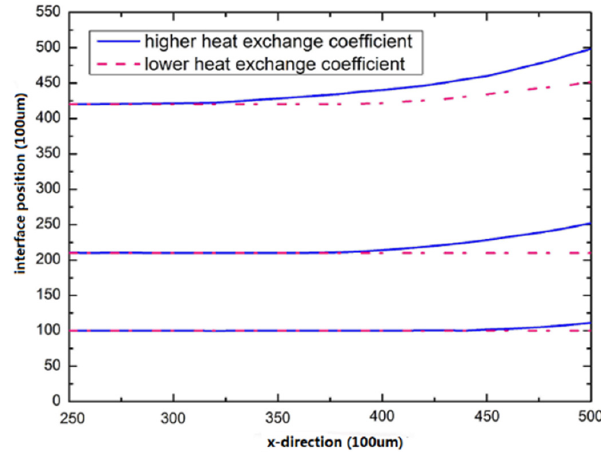
Figure 5. The evolution of the crystal ‐ melt interface with different heat transfer coefficients on the side boundaries during mc ‐ Si ingot growth.